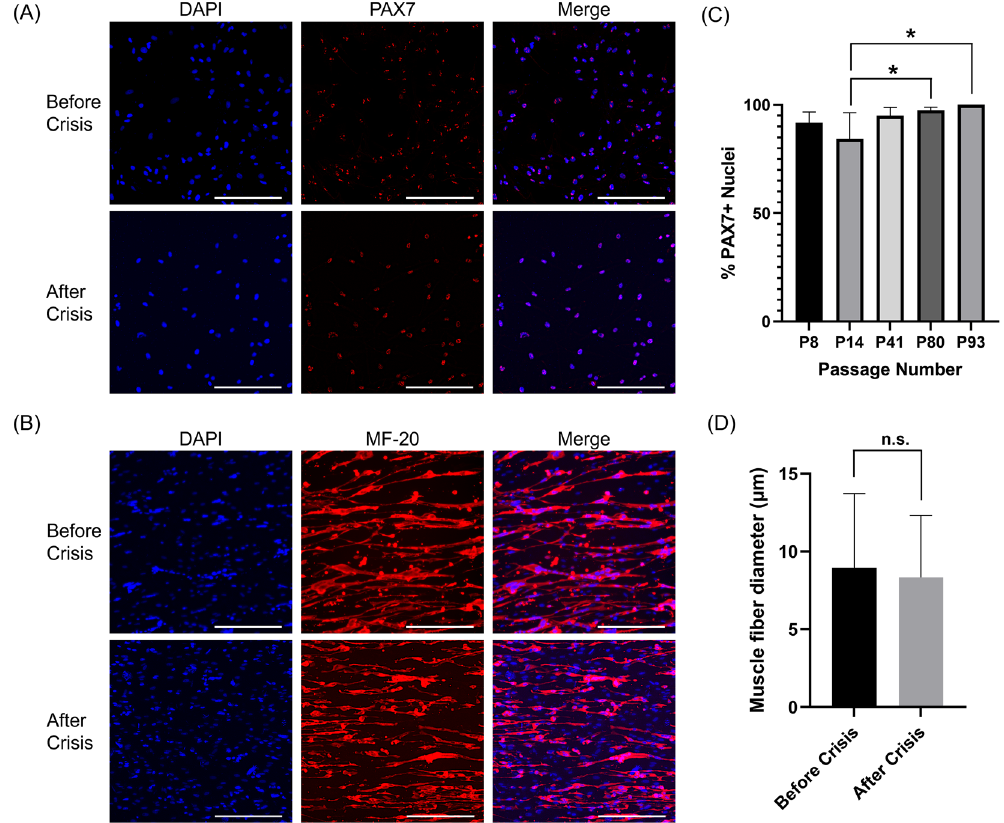
Figure 3. Myogenic potential and differentiation of Mack1 cells. ( A ) Immunofluorescence staining for cell nuclei (DAPI, blue) and PAX7 (red). Top and bottom panels are for passage numbers 14 and 93, respectively. Scale bars 100 μm. ( B ) Immunofluorescence staining for cell nuclei (DAPI, blue) and MHC (MF-20, red). Top and bottom panels are for passage numbers 8 and 56, respectively. Scale bars 100 μm. ( C ) Percent PAX7 + nuclei over multiple passages, as calculated through image analysis. Error bars indicate standard deviation, n = 3 or 6; statistical significance calculated by two-way ANOVA with multiple comparisons between the passage numbers and indicated by asterisks, in which p < 0.05 (*). ( D ) Muscle fiber diameter comparison between cells from passage numbers 8 and 93, through image analysis. Error bars indicate standard deviation, n = 20; no